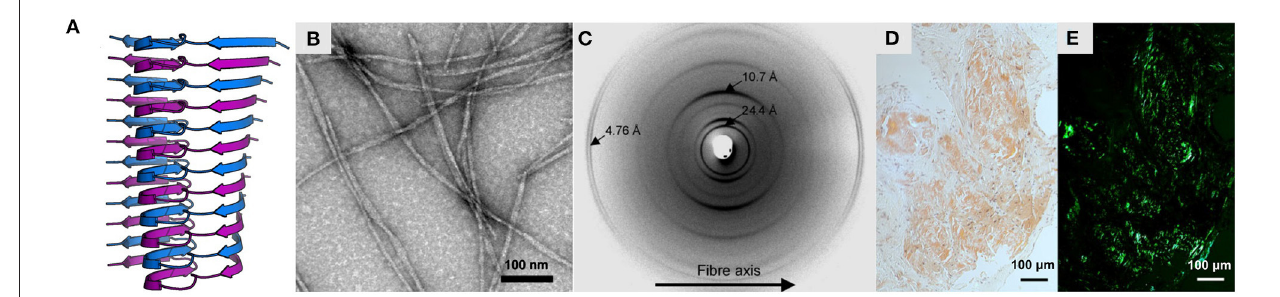
FIGURE 1 | Characteristics of amyloid fibrils. (A) Structure of A β (1-42) fibrils produced in vitro , obtained by solid-state NMR spectroscopy (PDB ID: 2mxu; Xiao et al., 2015). The structure is shown as a ribbon diagram, with stacked monomeric subunits alternately colored blue and purple. (B) Negative-stain electron micrograph of the same fibrils, adapted with permission from Xiao et al. (2015). (C) X-ray fiber diffraction pattern of partially aligned amyloid fibrils formed by the KFFEAAAKKFFE peptide, reproduced with permission from Makin et al. (2005) (Copyright 2005 National Academy of Sciences). (D,E) Light microscopy images of light chain amyloid stained with Congo red dye, under (D) normal illumination and (E) polarized light, reproduced with permission from Swuec et al. (2019). Note the green birefringence under polarized light, indicative of cross- β